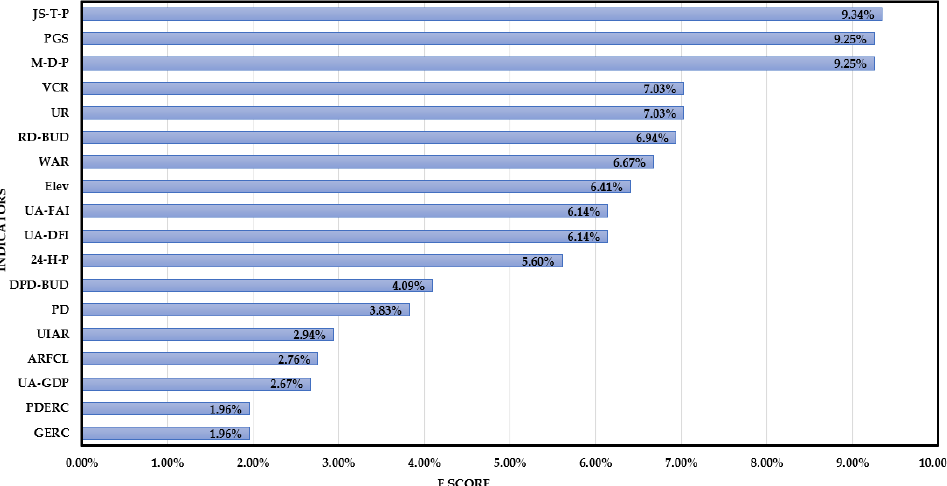
Figure 7. The importance of each indicator to rainstorm disaster risk.